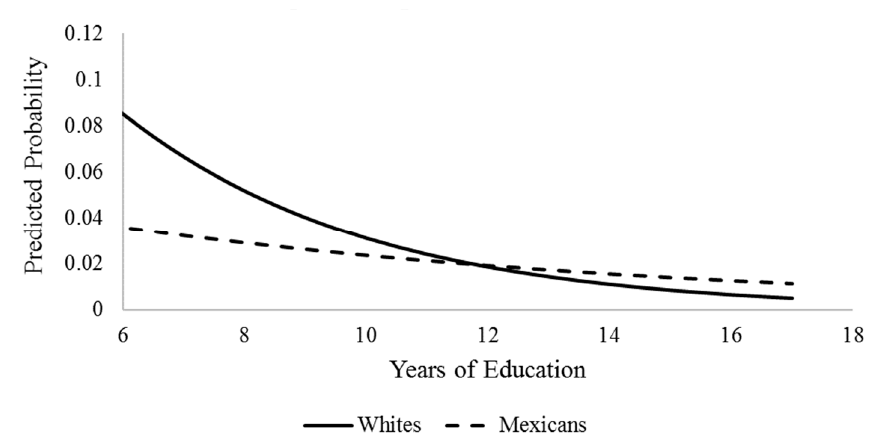
Figure 2. Ethnicity by Education Interaction Predicting Cognitive Impairment, HRS 2012.